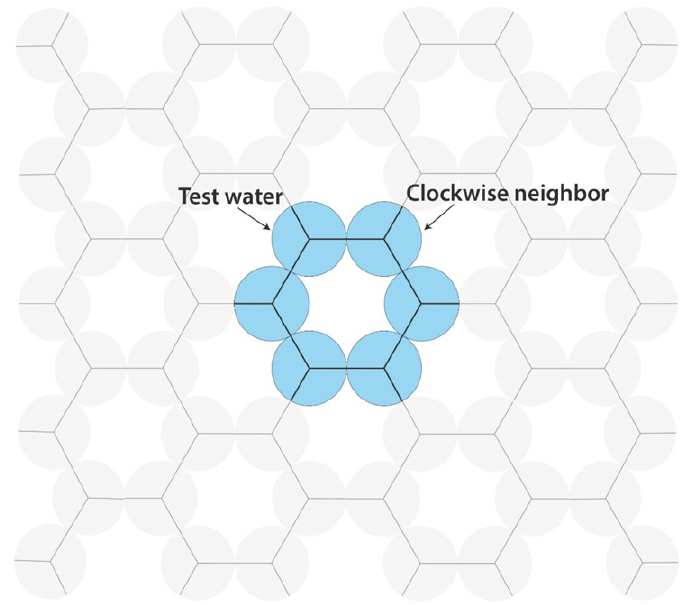
Figure 3: The lattice of the model showing both the hexagon of the icelike structure and illustrating a pair interaction used for bookkeeping to avoid triple